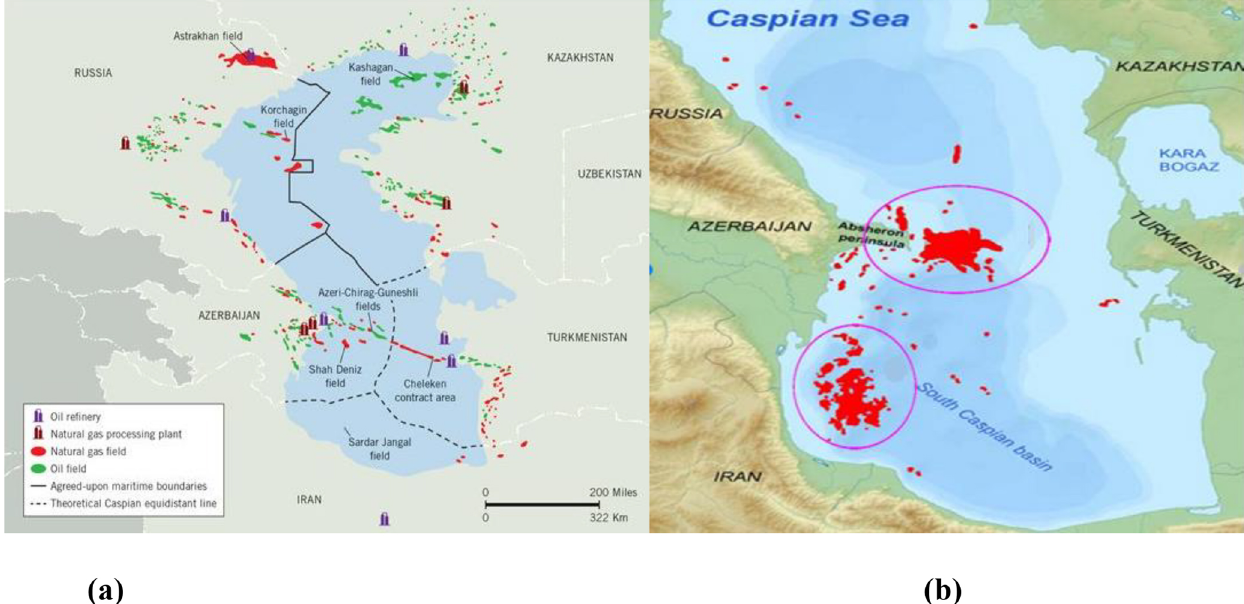
Figure 16. (a) The locations of oil and gas fields in the Caspian Sea, extracted from https://www.offshore-mag.com (last access: 11 September 2013). (b) A map of oil spills revealed from satellite radar imagery in the central and southwestern parts of the Caspian Sea in 2010 (Mityagina and Lavrova,